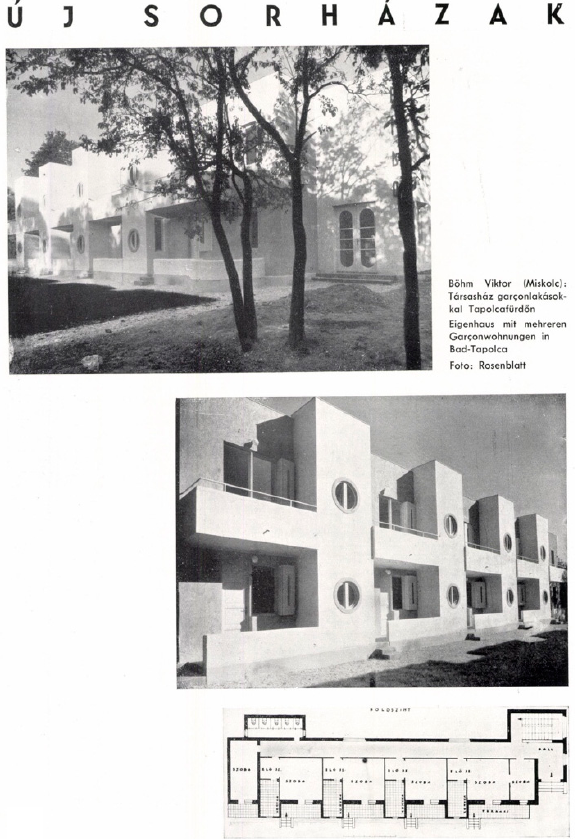
Figure 1. Detached house in Miskolctapolca. Architect: Victor Bohm, 1933. Source: ( Tér és Forma 1934), vol. 7, no. 2, p. 58.